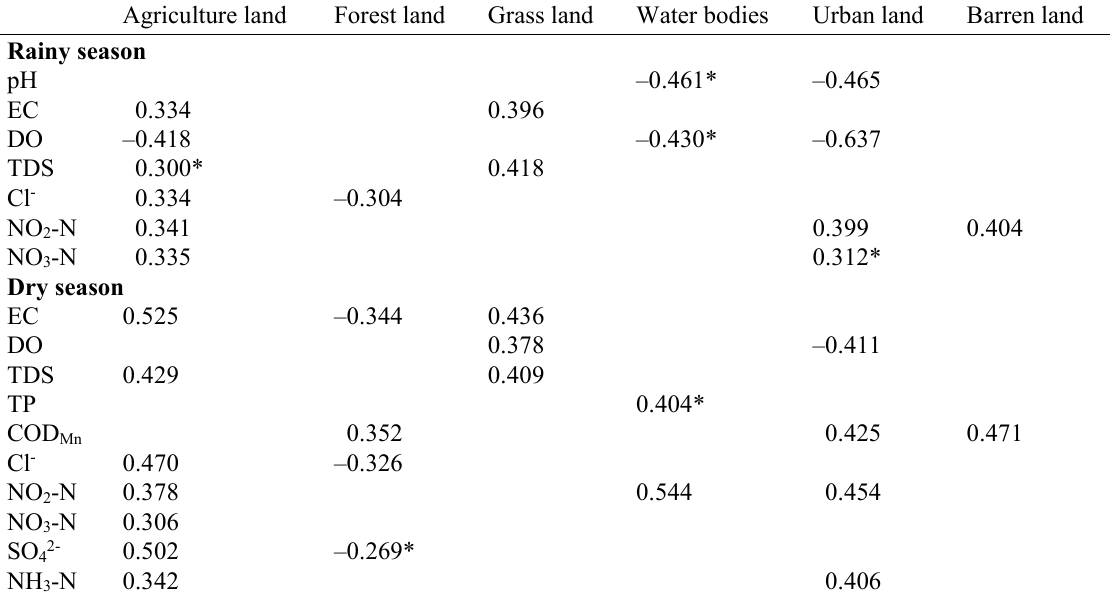
Table 1 Pearson’s correlation coefficients between land-use types and water quality chemistry during both rainy and dry seasons.